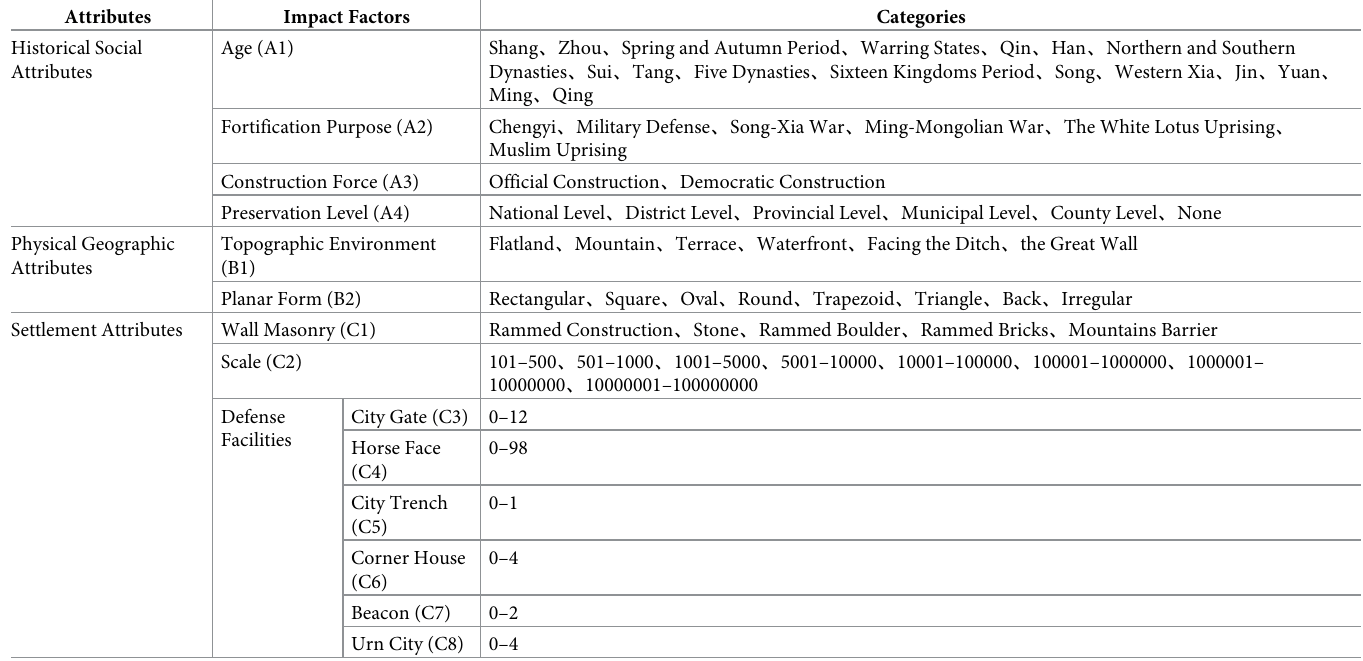
Table 1. Quantitative index